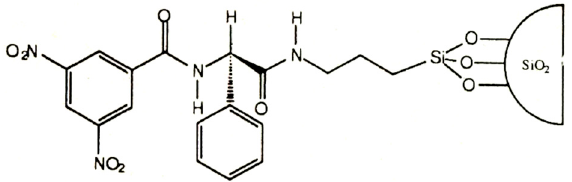
Figure 18. N -(3,5-dinitrobenzoyl)-phenylglycine (DNBPG) bonded to silica. Reprinted with permission from [81]. Copyright (1990) American Chemical Society.